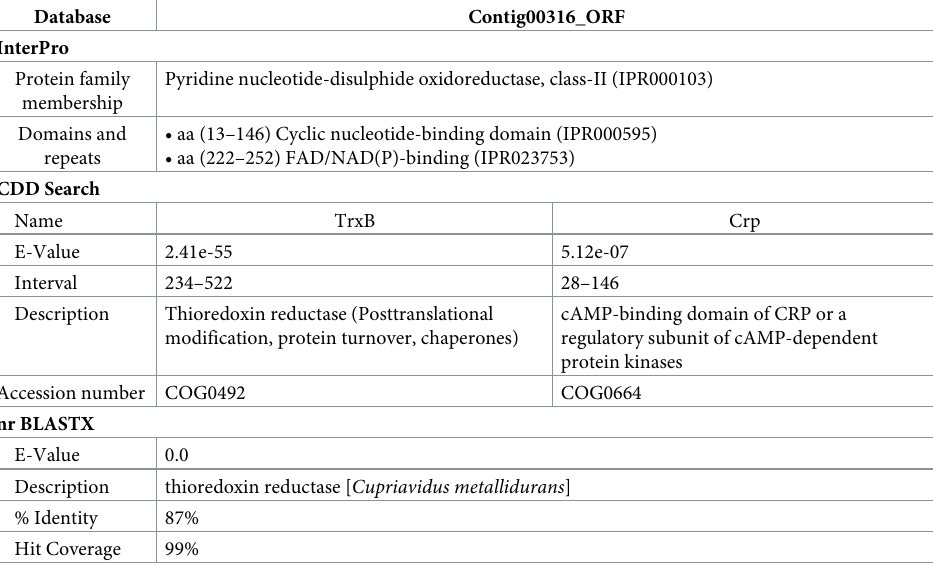
Table 1. InterPro, CDD and nr Blastx search results for the open reading frame (ORF) selected in this